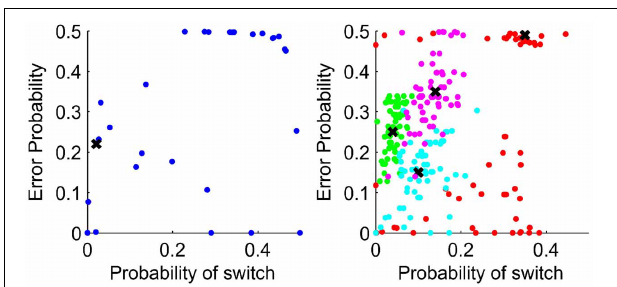
FIGURE 6 | Left: Parameters fit to participant data for the HMM with the parameters to match the experimental generation of data shown by a cross. Right: Parameter values chosen to generate responses using the HMM are shown by crosses. Parameter estimates for the generated data are shown as dots. The probability of switch uses the assumption in the HMM that the environment switches from one in which rule 1 applies to rule 2 applies, and vice versa, with the same constant probability. The error probability is the probability of negative feedback when using the response type corresponding to the environmental rule which applies.